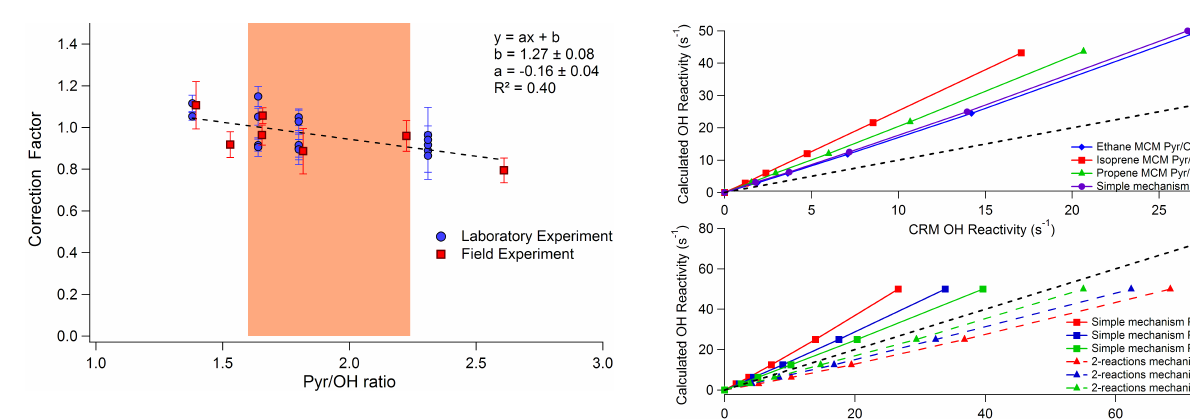
Figure 7. Dependence of the correction factor F on the pyrrole- to-OH ratio. The correction factors were derived from the slopes of scatterplots as shown in Fig. 6 for different laboratory (blue cir- cles) and field (red squares) experiments. These experiments were made over a period of 7 months. Error bars are 1 σ uncertainties of the slopes determined for each experiment. The colored area is the range of pyrrole-to-OH ratios observed in the field (1.6–2.2) for the MD-CRM instrument.